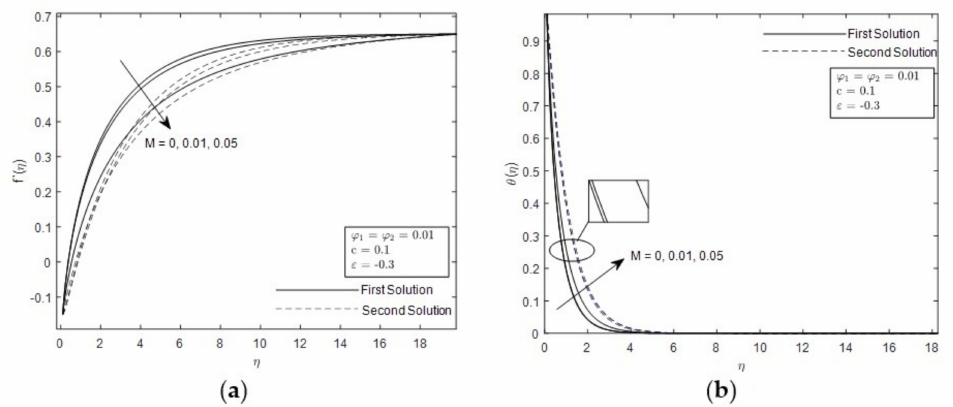
Figure 9. ( a ) Effects of M on f (cid:48) ( η ) . ( b ) Effects of M on θ ( η ) .